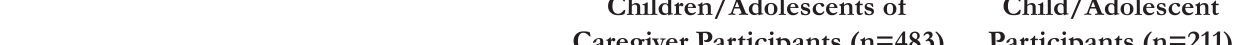
Children/Adolescents of Child/Adolescent Caregiver Participants (n=483) Participants